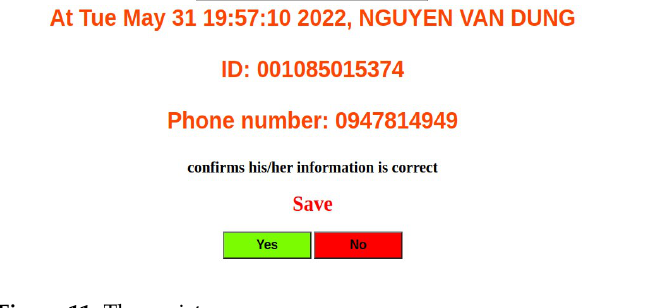
Figure 11. The register